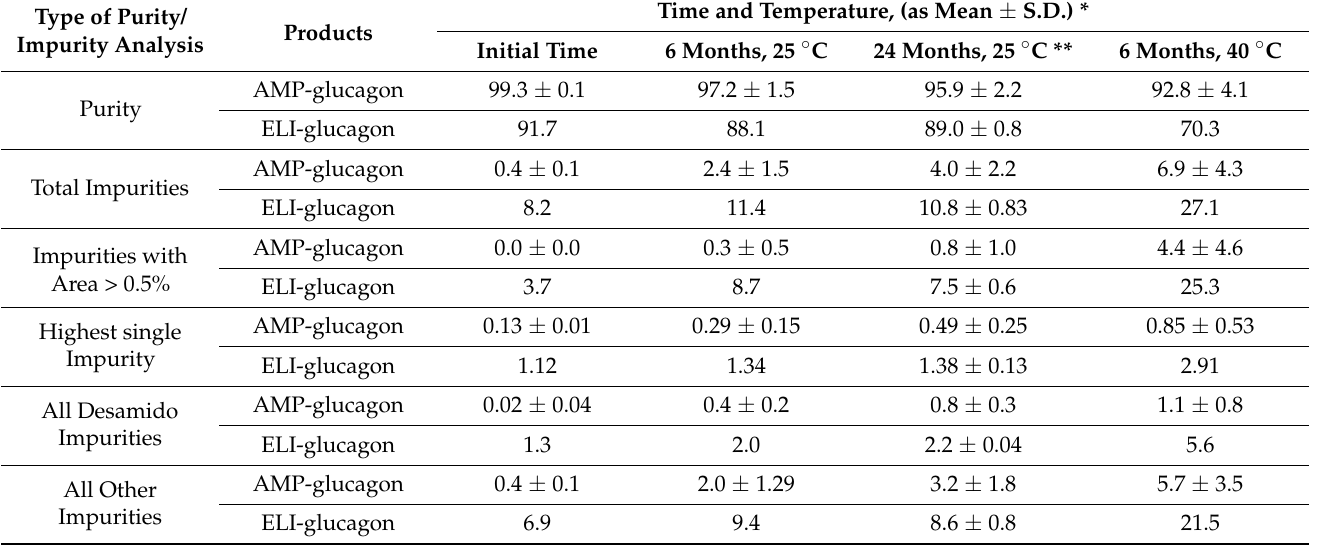
Table 4. Summary of the purity and impurity profiles (%) for glucagon for injection under various stability